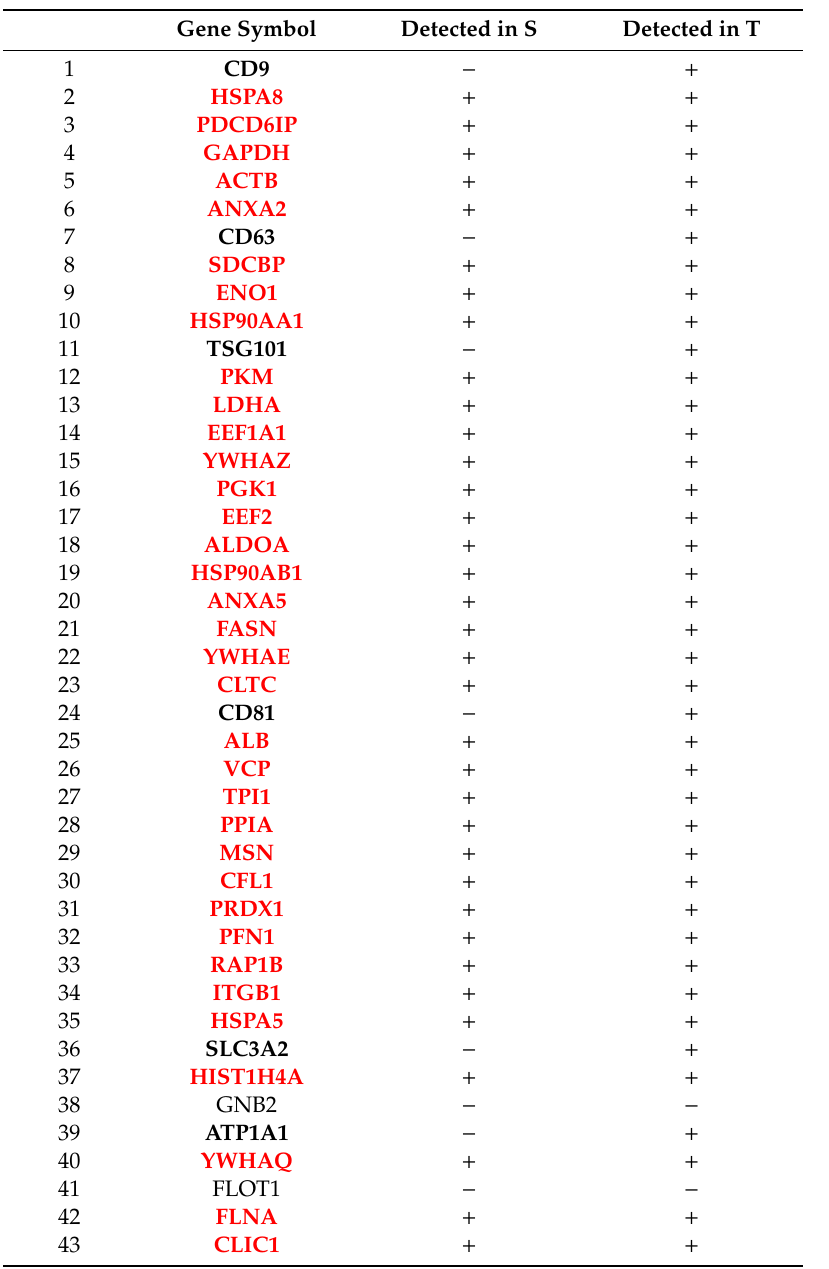
Table 1. List of the top 100 ExoCarta proteins present in the brain endothelial extracellular vesicle (EV) surface (S) and total (T) proteome. Bold, top 100 ExoCarta proteins present in S or T; bold and red, proteins present in both S and